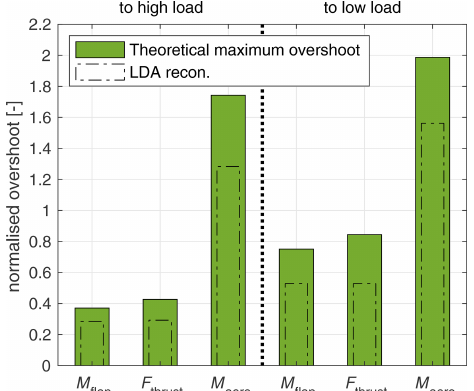
Figure 22. Theoretical dynamic overshoot for the step to high and low loads for the integral turbine loads M flap , F thrust and M aero , based on reconstruction from the LDA data, assuming an infinitely fast pitch step in comparison to the LDA recon. case from Fig.